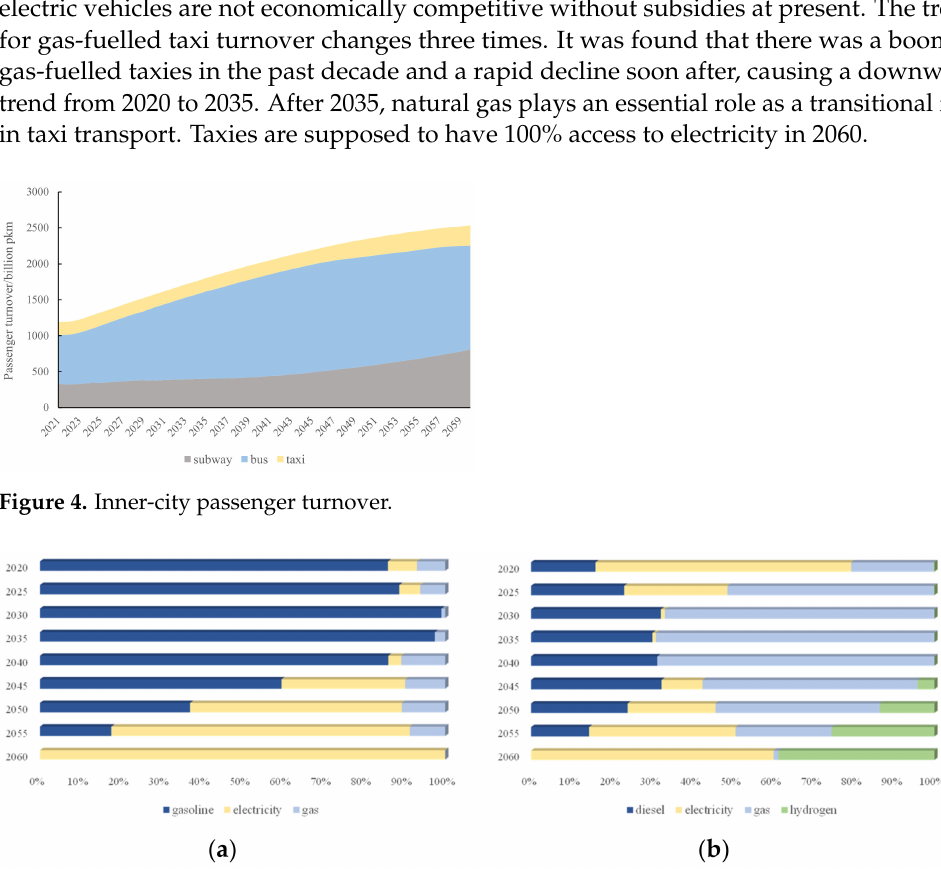
Figure 5. The structure of each inner-city passenger transport mode. ( a ) The structure of taxi turnover. ( b ) The structure of bus